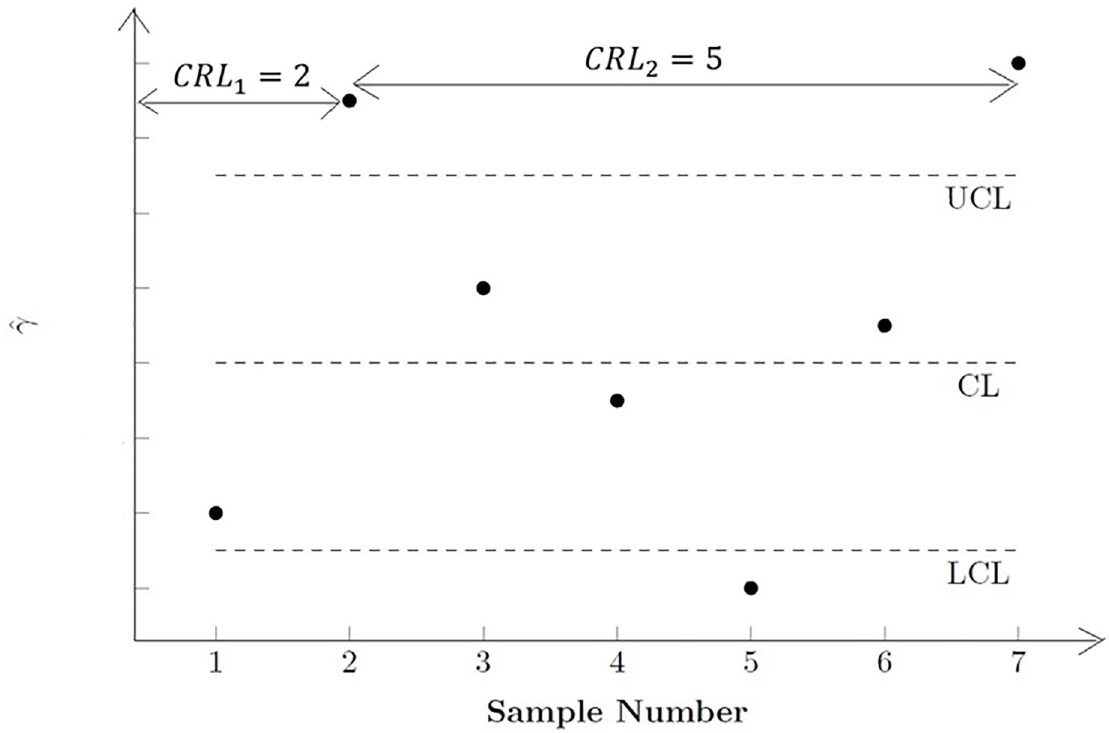
Fig 1. The CRL sub-chart of the side-sensitive synthetic- γ